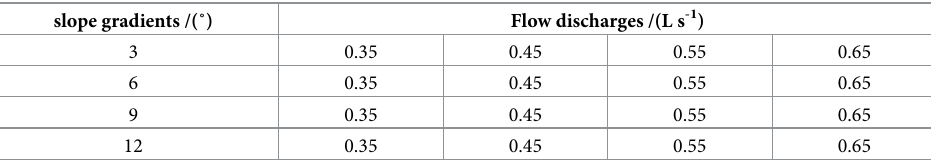
Table 2. Design of experiment.